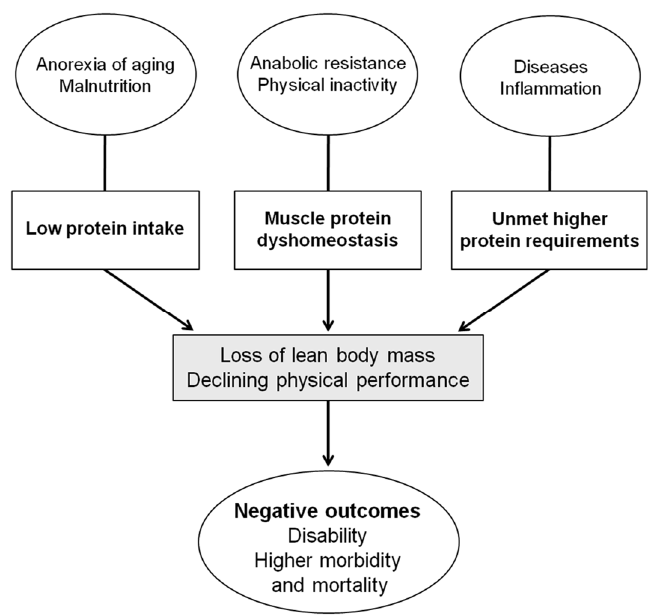
Figure 1. Alterations in protein homeostasis during aging and related clinical outcomes.